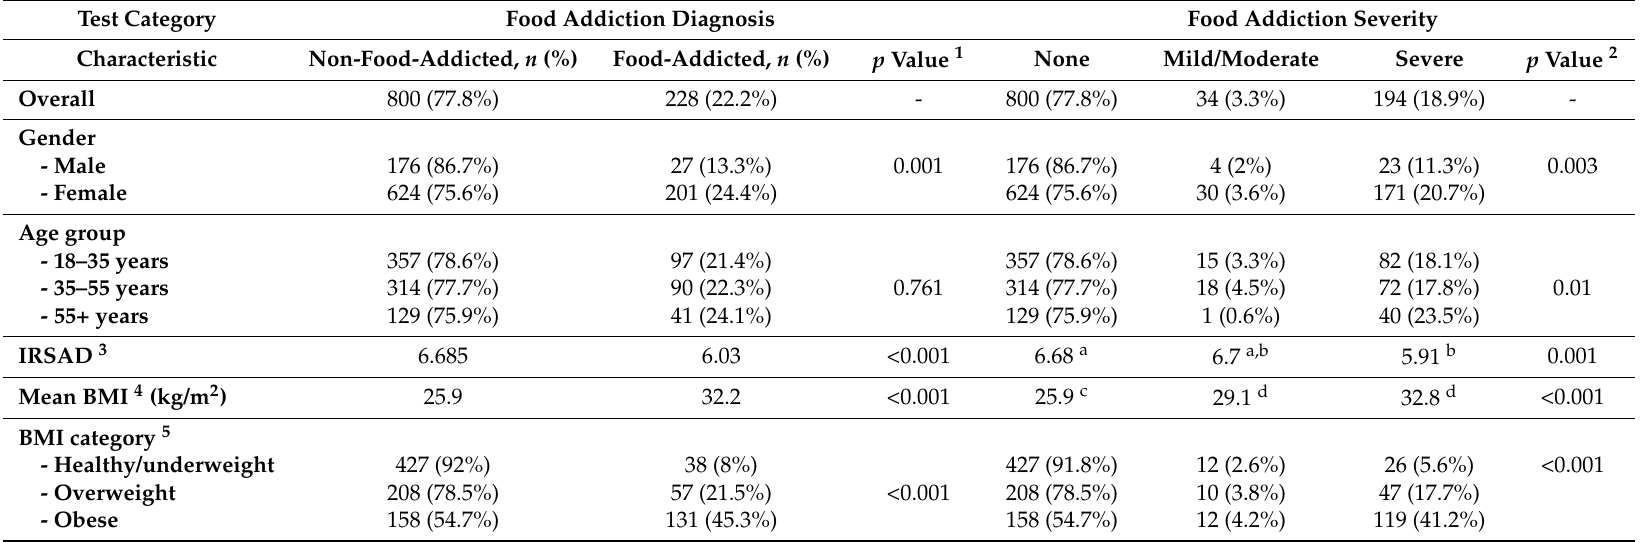
Table 1. Demographics of participants by Food Addiction diagnosis and Food Addiction